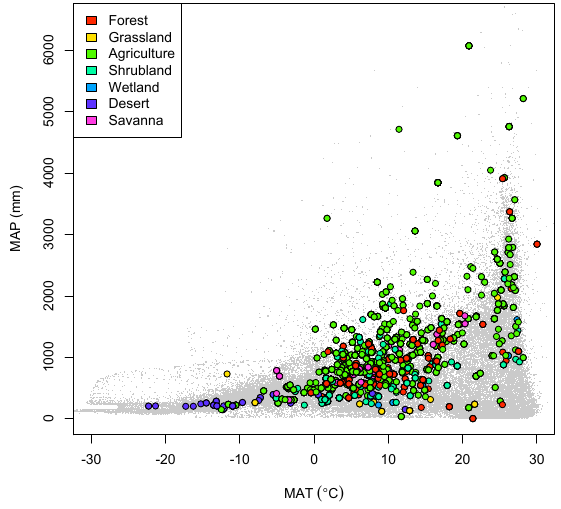
Fig. 4. Annual soil respiration ( R S ) fluxes observed in the field, un- manipulated plots only, by biome. Relative histograms are shown; total observations are N = 17, 180, 1053, 51, 46, and 215 for Arctic, boreal, temperate, Mediterranean, subtropical, and tropical respec-